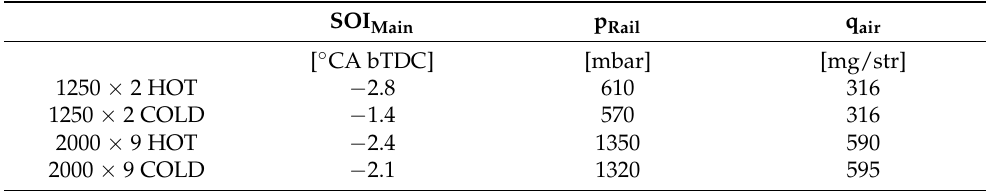
Table 5. Setpoint values for the “central points” along calibration parameter sweeps. Setpoints are fuel